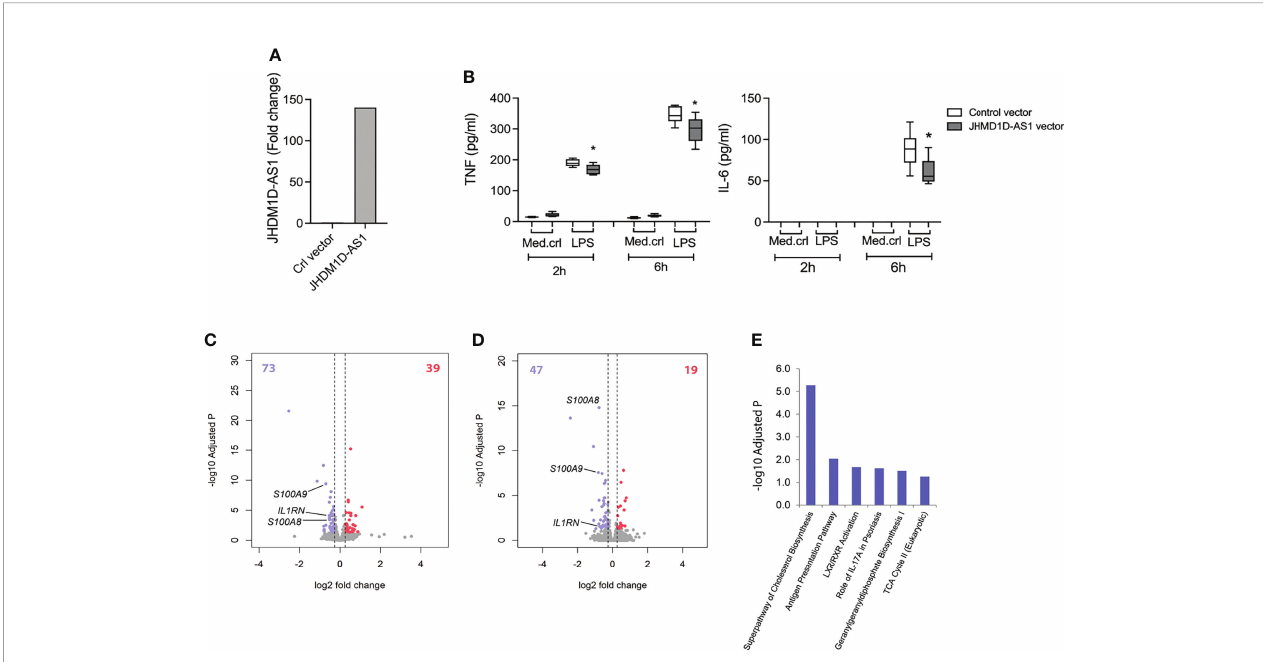
FIGURE 3 | Overexpression of JHDM1D-AS1 in THP-1-MD2-CD14 pro-monocytic cells leading to reduced in fl ammatory responses upon LPS stimulation. (A) RT- qPCR analysis of JHDM1D-AS1 levels in THP1-MD2-CD14 cells expressing ectopic JHDM1D-AS1 or empty vector control. (B) Boxplots depicting secreted levels of TNF and IL-6 in supernatants of THP1-MD2-CD14 cells expressing ectopic JHDM1D-AS1 or empty vector (control), exposed to LPS (100 ng/ml) or medium control for 2 or 6 h, quanti fi ed by ELISA. The boxes extend from the 25th to 75th percentiles, the whiskers range from minimum to maximum, and the horizontal line indicates the median. Unpaired student ’ s t-tests were performed for the indicated comparisons with *p < 0.05. (C, D) Volcano plots illustrating signi fi cantly altered RNA transcripts after LPS stimulation for (C) 2 h and (D) 6 h. Red denotes elevated expression (adjusted p < 0.05, fold change ≥ 1.5); blue denotes reduced expression (adjusted p < 0.05, fold change ≤ − 1.5). (E) Signi fi cantly downregulated genes after 6-h LPS exposure were associated to Ingenuity canonical signaling